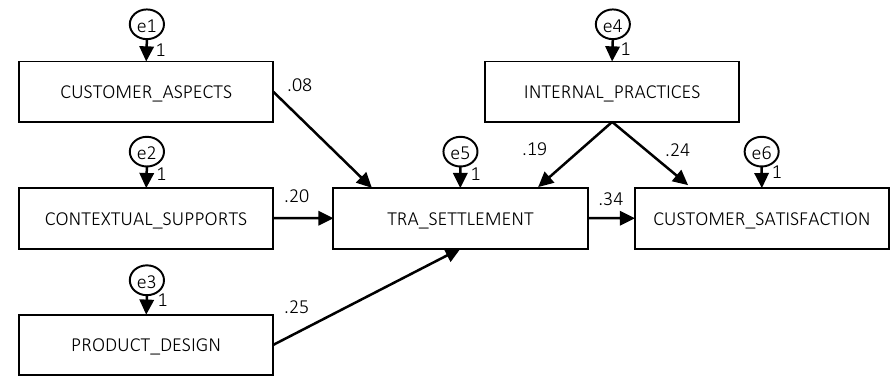
Figure 2. Aggregate effect modeling: